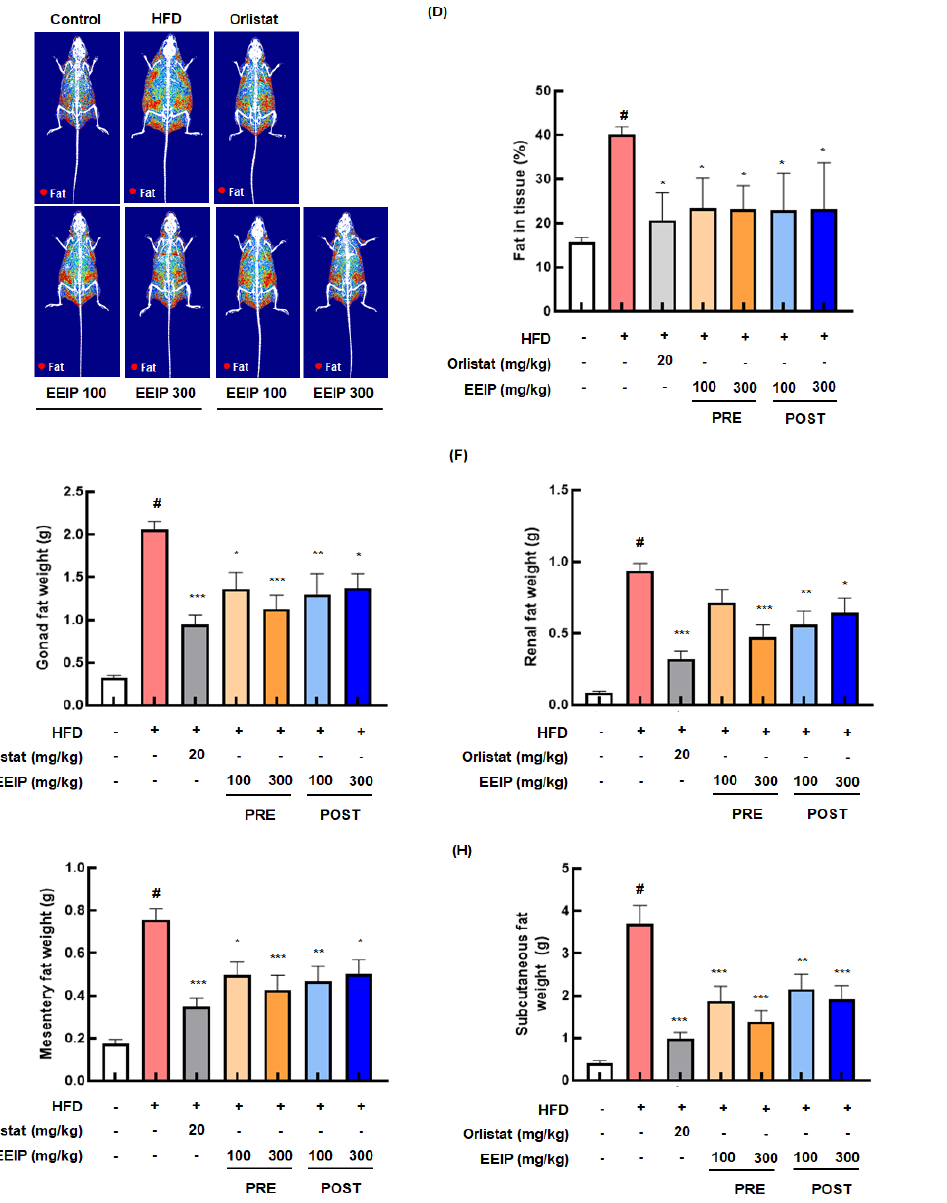
Figure 4. Effect of EEIP on body weight and body fat in HFD-fed obese mice. The pre−administration group was administered EEIP from the 1st week, and the post-administration group was administered EEIP from the 10th week. ( A ) Weekly change in body weight and ( B ) the final body weight. ( C ) The fat distribution, presented with a radiography image, and ( D ) the calculated values of fat in the tissue are measured using DXA. ( E ) Gonad, ( F ) renal, ( G ) mesentery, and ( H ) subcutaneous fat weight. Values are represented as the mean ± SEM. # p < 0.05 vs. normal diet control group; * p < 0.05, ** p < 0.01, and *** p < 0.001 vs. HFD group.